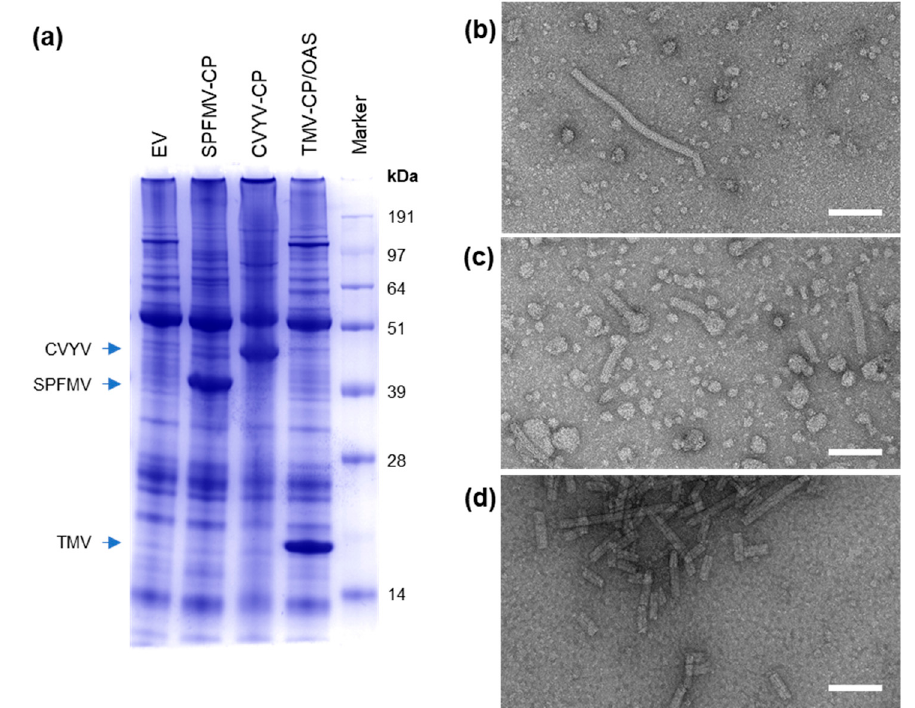
Figure 3. pEff allows for high-level production of filamentous VLPs from different plant virus families. Analysis of crude protein extract by Coomassie-stained SDS-PAGE ( a ). TEM images of particles from clarified extracts of pEff-SPFMV-CP ( b ), pEff-CVYV-CP ( c ) and partially purified pEff-TMV-CP/OAS ( d ). Scale bars 100 nm.